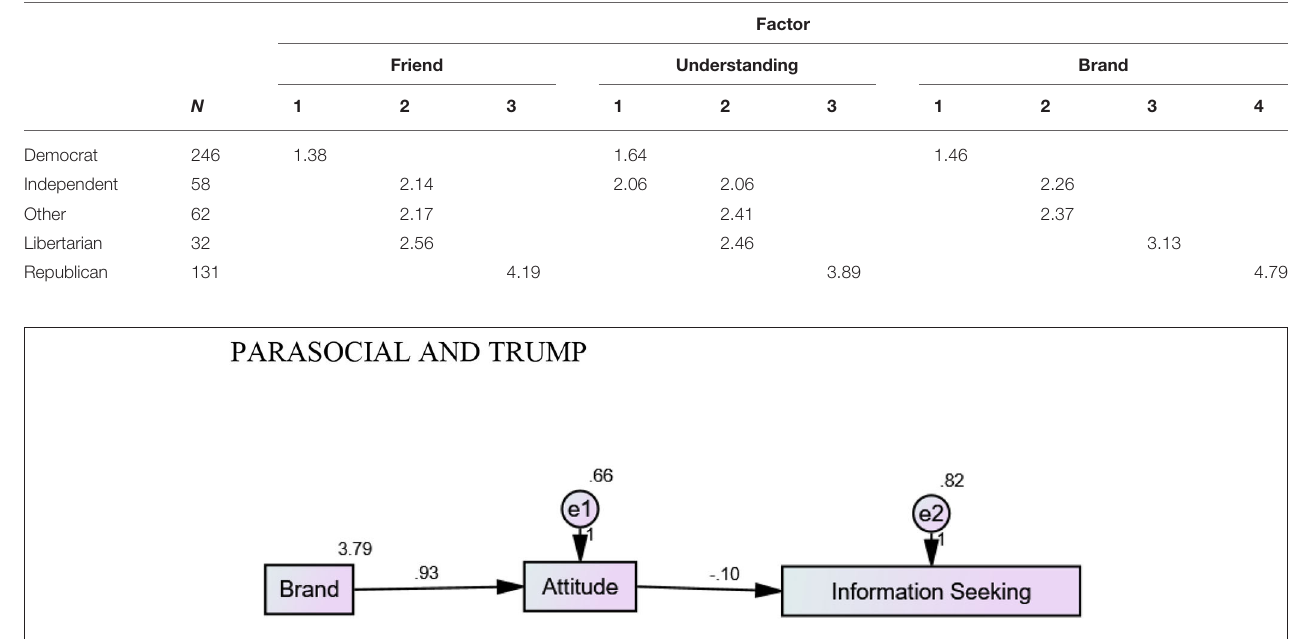
TABLE 4 | Tukey summary hypothesis 2.